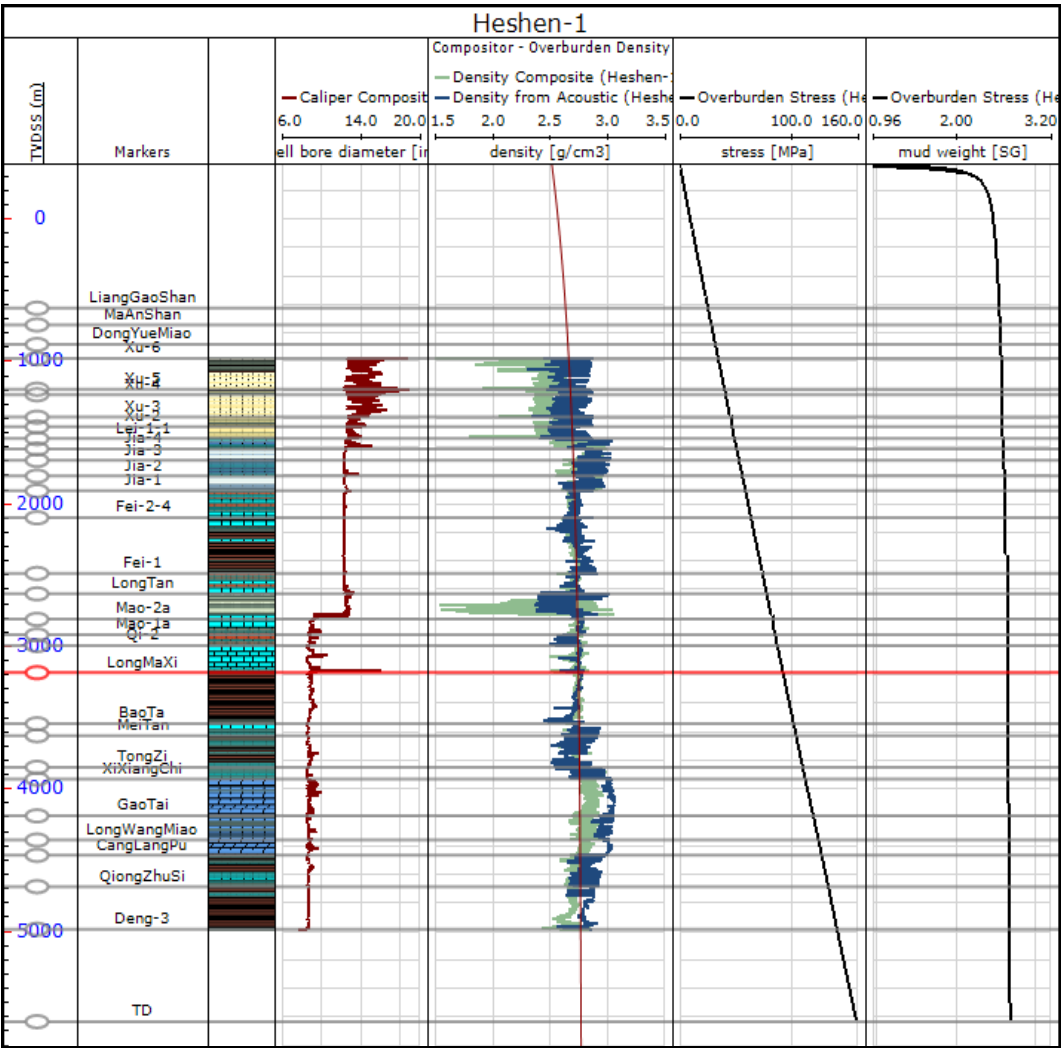
Figure 2. Estimation results of the overburden gradient in H1 well.